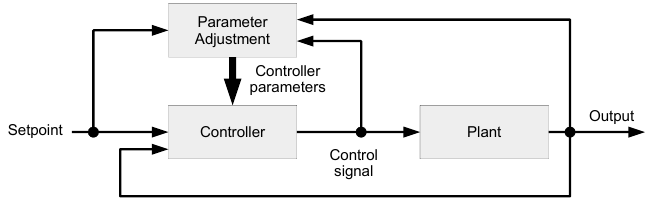
Figure 2. Block diagram of an adaptive control system.